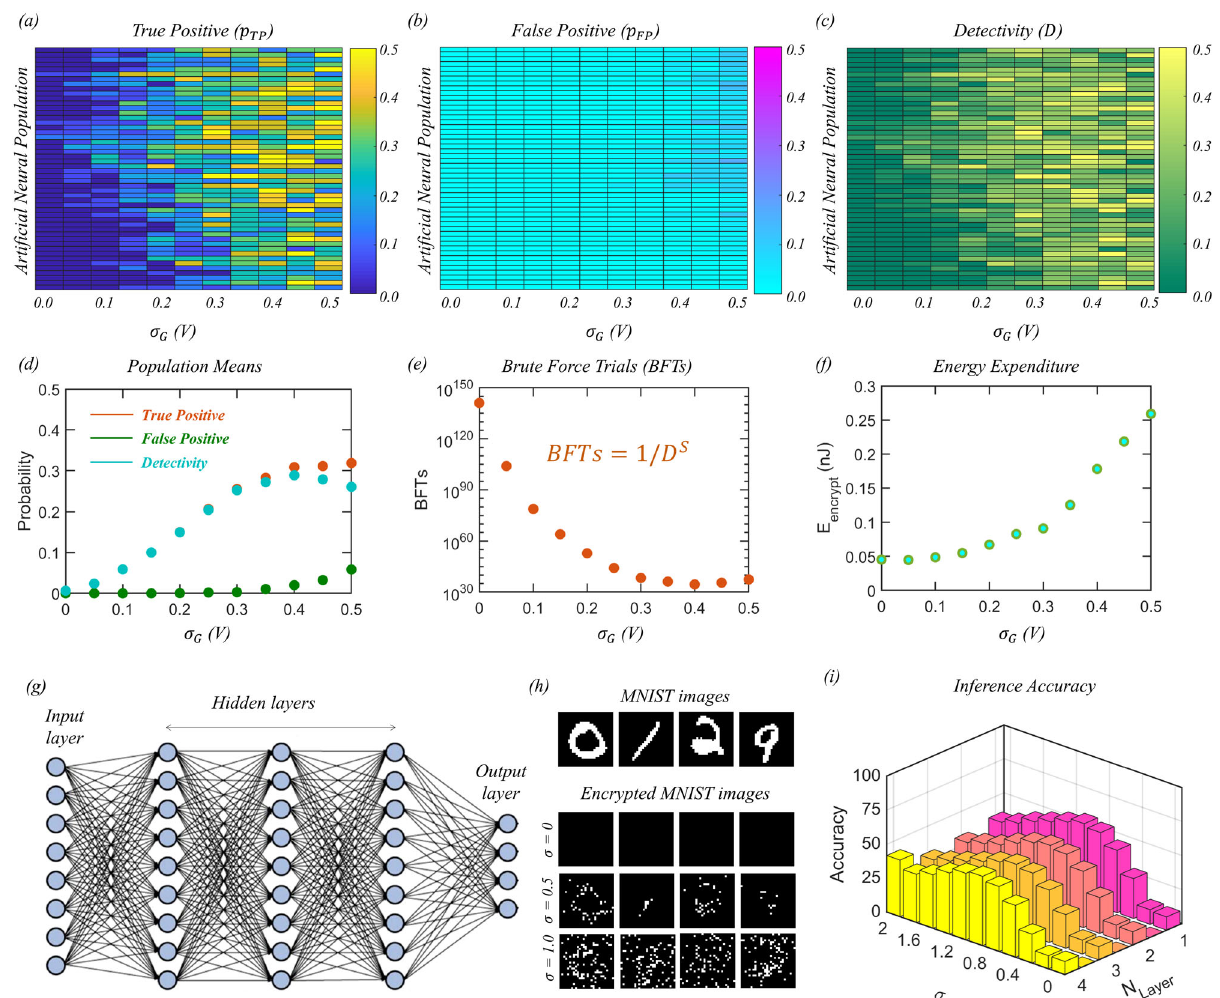
Fig. 4 Encryption strength. Colormaps of the likelihood, or probability, of ( a ) true positive ( p TP ), ( b ) false positive ( p FP ), and ( c ) detectivity ( D ¼ p TP (cid:2) p FP ) as a function of σ G for P = 50 encoders. d Corresponding population means. True positive (TP) is an event when a bright pixel in the encoded image corresponds to a bright pixel in the original image, and false positive (FP) is an event when a bright pixel in the encoded image corresponds to a dark pixel in the original image. e The number of brute force trials (BFTs) by the eavesdropper necessary to identify the letter ‘ N ’ as a function of σ G . Note that BFT = 1 = D S , where S = 8 × 8 = 64 is the size of the image. f The average energy expenditure for the encryption process as a function of σ G . g A deep neural network (DNN) trained to recognize the MNIST data set for digit classi fi cation. The training and testing sets consisted of 60,000 and 10,000 images, respectively. h Representative MNIST images with white Gaussian noise (WGN) of different standard deviations ( σ ) binarized at a threshold of 1.5, mimicking our MoS 2 memtransistor-based encryption process. i Average inference accuracy for 10,000 encrypted images as a function of σ and the number of hidden layers ( N Layer ). Irrespective of σ , the inference accuracy remains low, indicating the robustness of our bio-inspired encryption to trained